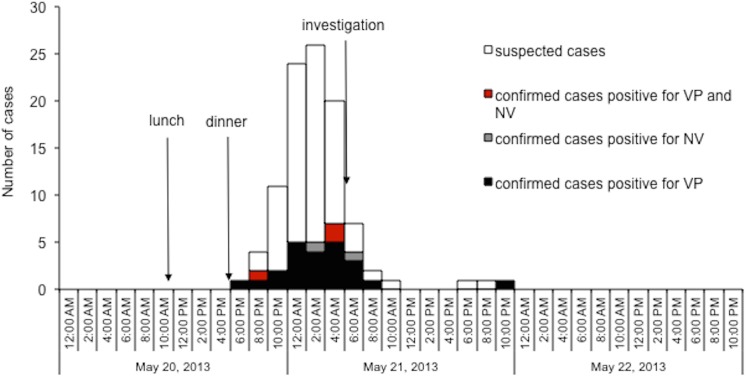
Epidemic curve of the outbreak showing the 99 cases of staff members